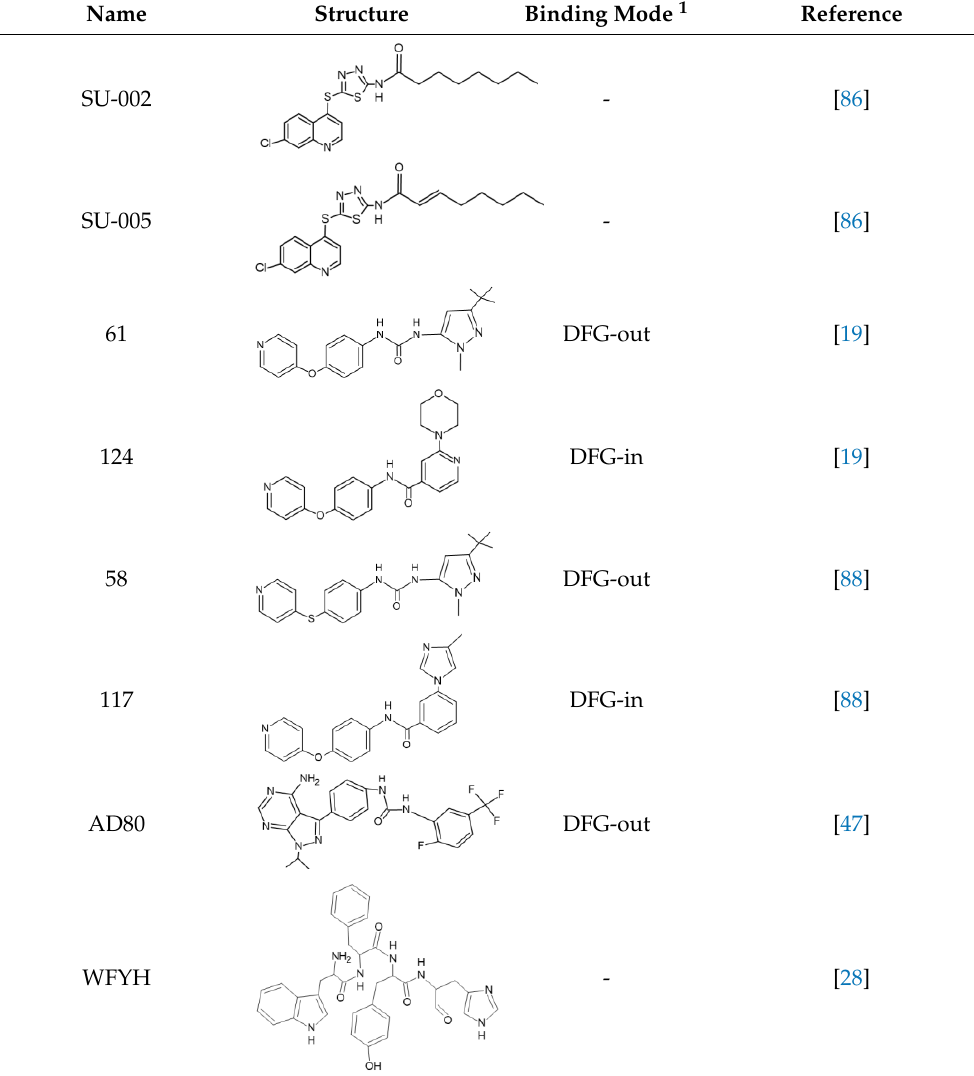
Table 1. Structures of potential p38 δ inhibitors. Table 1. Structures of potential p38δ inhibitors. Table 1. Structures of potential p38δ inhibitors. Table 1. Structures of potential p38δ inhibitors. Table 1. Structures of potential p38δ inhibitors. Table 1. Structures of potential p38δ inhibitors. Table 1. Structures of potential p38δ inhibitors. Table 1. Structures of potential p38δ inhibitors. Table 1. Structures of potential p38δ